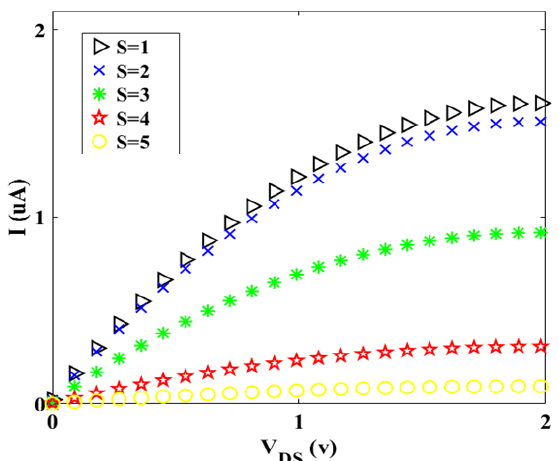
Figure 7. I-V characteristic for different values of S at room temperature (Z = 10).